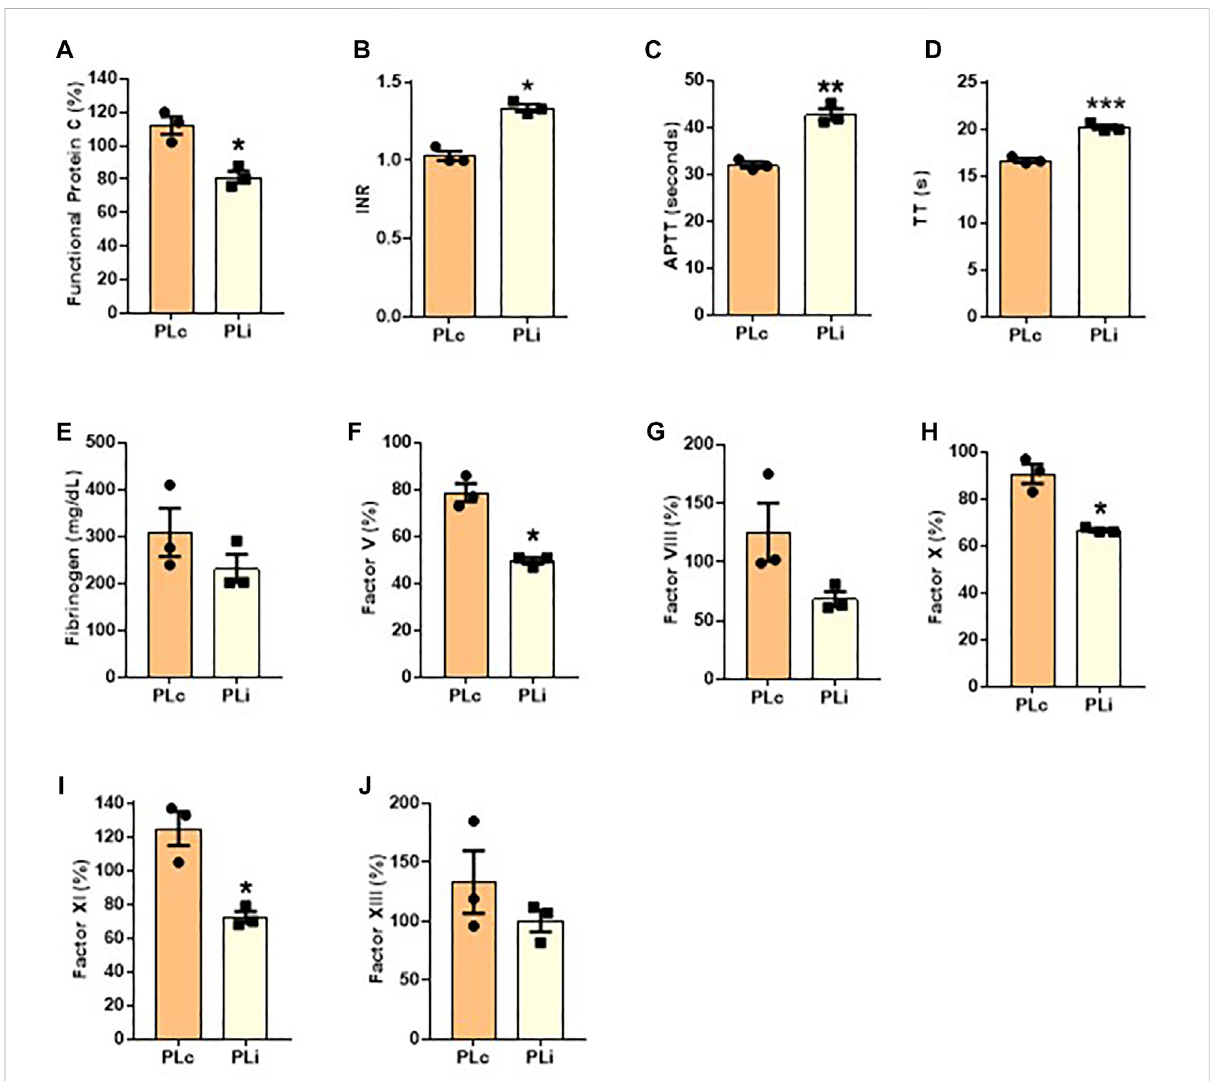
FIGURE 3 Coagulation pro fi le of human plasma after pathogen reduction. The following measurement were performed: (A) functional protein C, (B) international normalized ratio (INR), (C) activated partial thromboplastintime (APTT), (D) thrombin time (TT), coagulation factor (E) V, (F) X, (G) XI, (H) VIII, and (I) XIII and (J) fi brinogen. Data are shown as mean ± SEM.Threeindependentsamples per group wereanalyzed.Student ’ spaired t -test:* p < 0.05; ** p < 0.01; *** p <